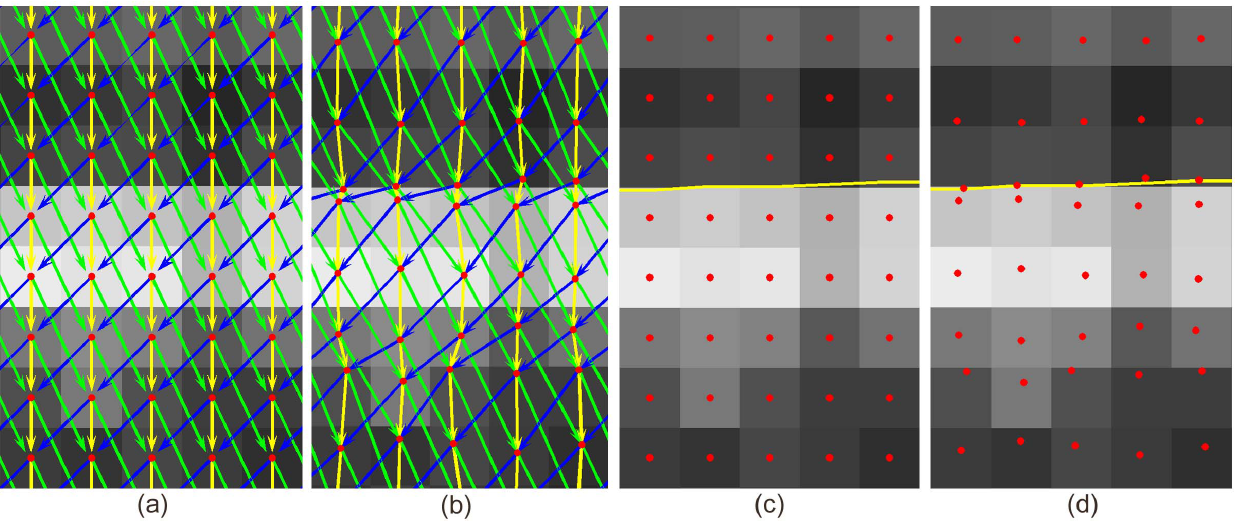
Figure 6. Comparison of conventional graph construction and Non-Euclidean deformed graph model. (a) Conventional graph structure; (b) Non-Euclidean deformed graph model; (c) Node distribution in conventional graph structure; (d) Node distribution in non-Euclidean deformed graph model. Node created within each pixel is shown as red dot. Intra-column arcs are shown as yellow arrows while inter-column arcs are shown as green and blue arrows, which represent smoothness constraints that can be incorporated in a typical graph search framework. The yellow curves indicate the desired dark-to-bright surface location mapped from high resolution B-scan.